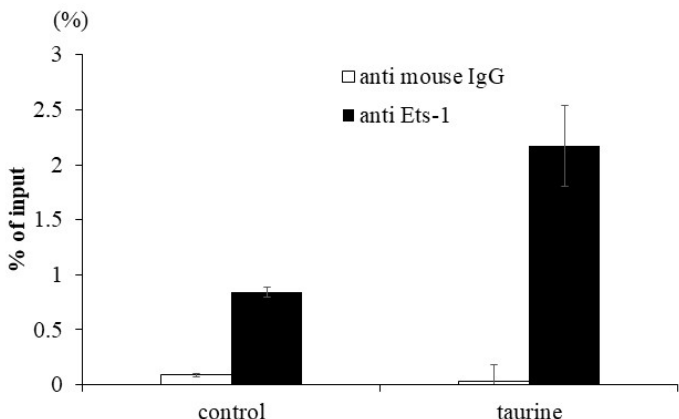
Figure 7. Effect of taurine on the binding of Ets-1 to the TXNIP promoter. Caco-2 cells were cultured in medium containing 100 mM of taurine. After 48 h, a ChIP assay was performed as described in Materials and Methods. The results are expressed as relative values with 100% being the DNA value before immunoprecipitation. Each value represents the mean ± S.E. ( n = 2).